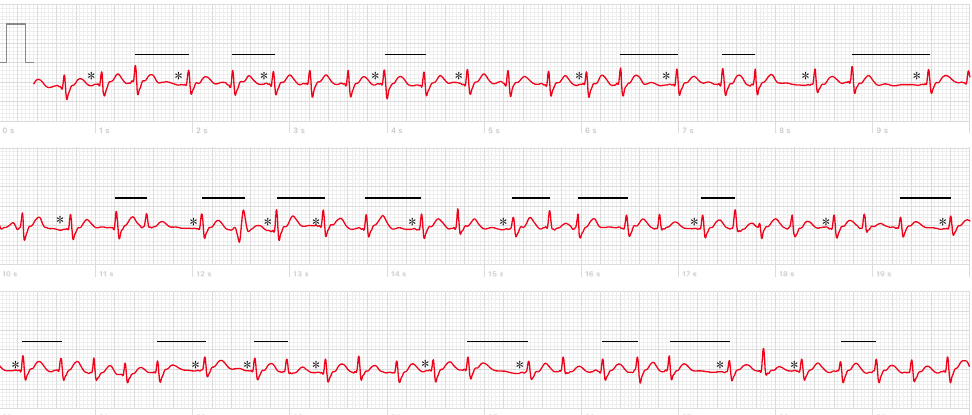
Figure 1. Baseline 1-lead ECG recorded by the patient using an Apple Watch Series 4 upon onset of palpitations showing narrow-complex tachycardia with rapid irregular ventricular rate (black lines) and absence of distinct repeating P waves (black asterisks).